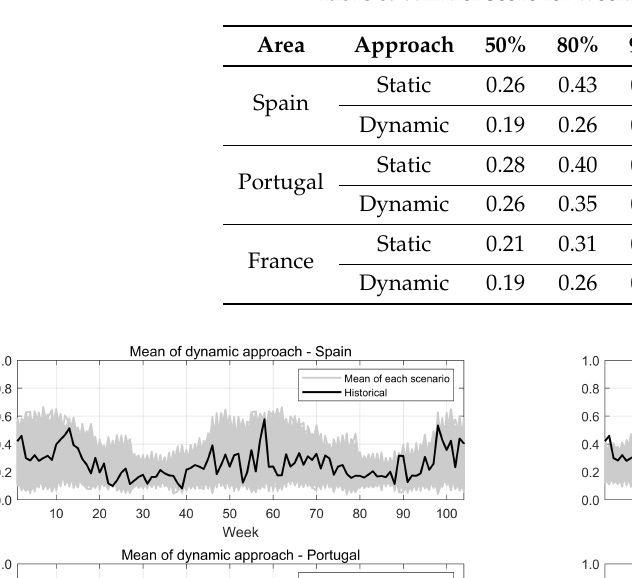
Table 8. Winkler score for weekly approach.